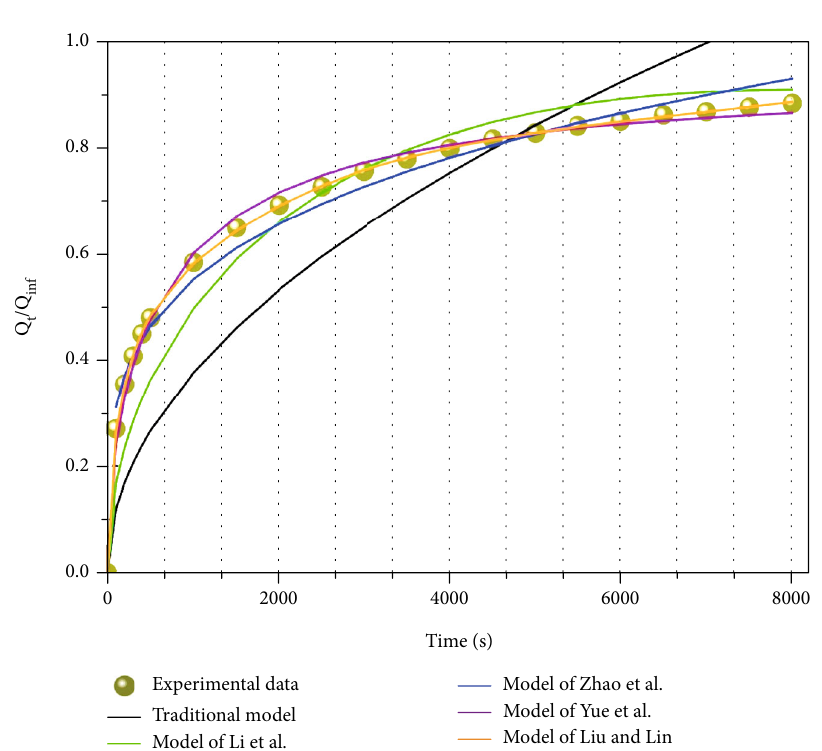
Figure 1: Fitting results of di ff erent di ff usion models with the experimental dada from Kang et al. [41] (note: Q is total gas di ff usion amount at time t , and Q inf